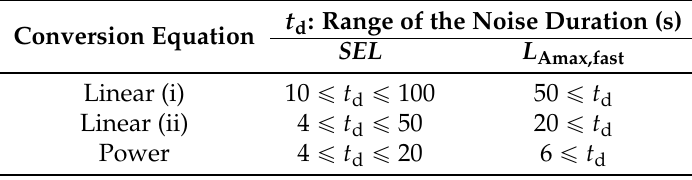
Table 2. Ranges over which the SEL or L Amax,fast values do not fluctuate more than